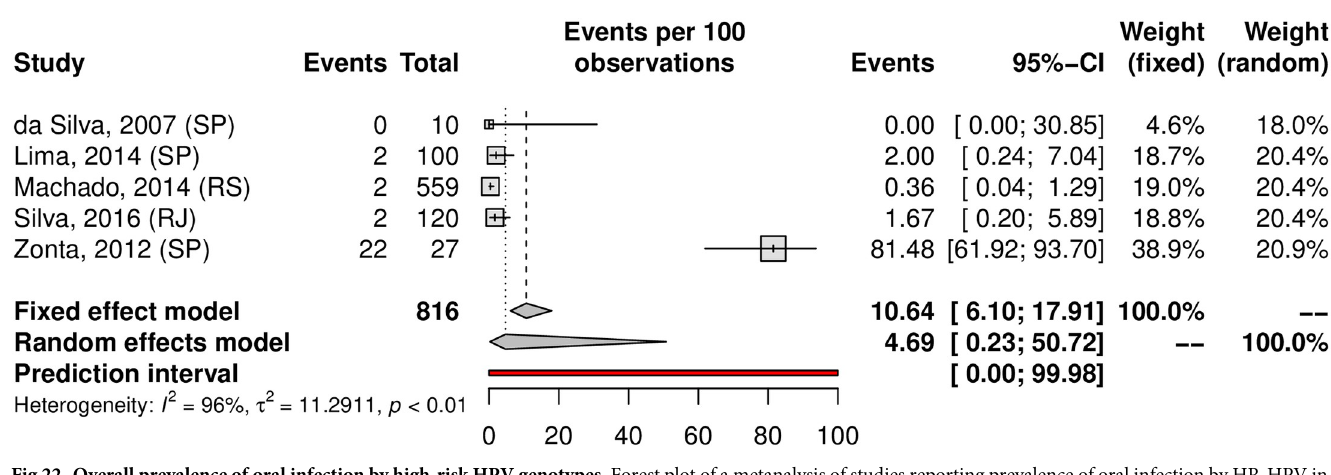
PLOS ONE | https://doi.org/10.1371/journal.pone.0229154 February 21, 2020 20 /